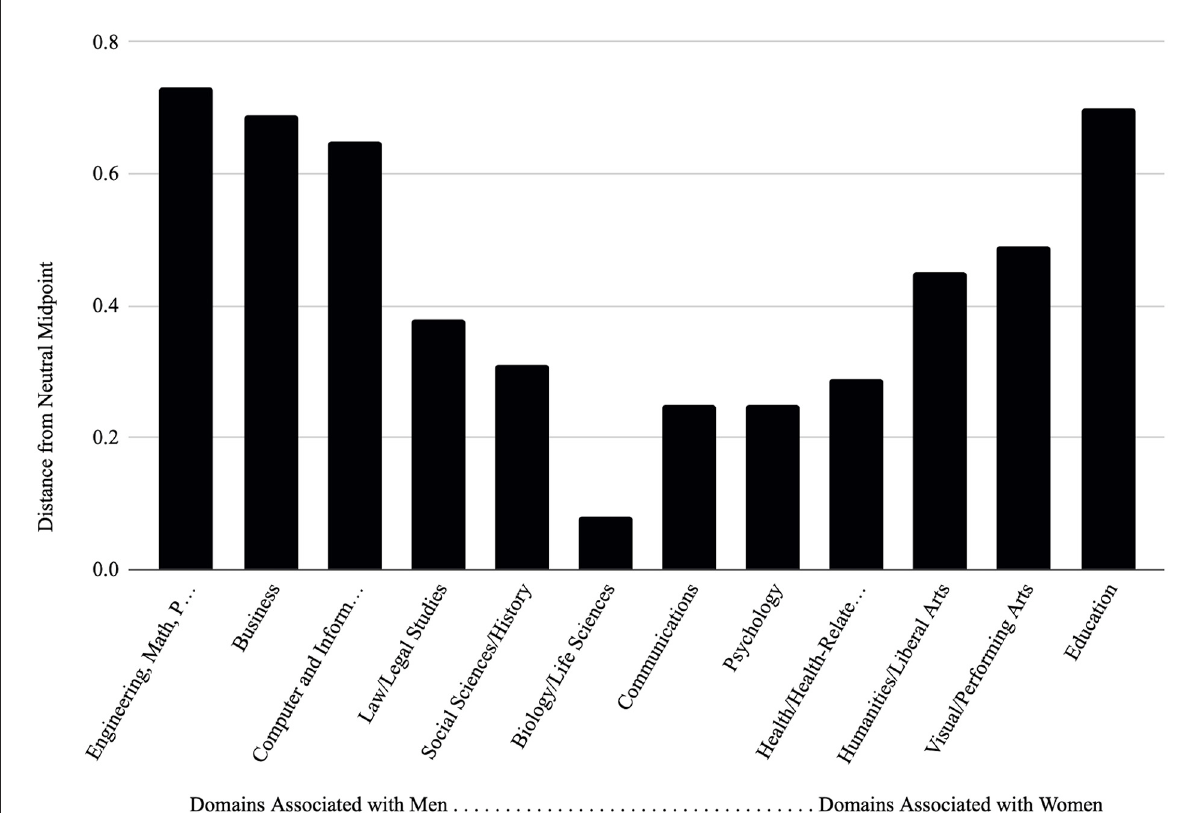
FIGURE1 Distribution of gendered association of academic disciplines; distance from the neutral midpoint.